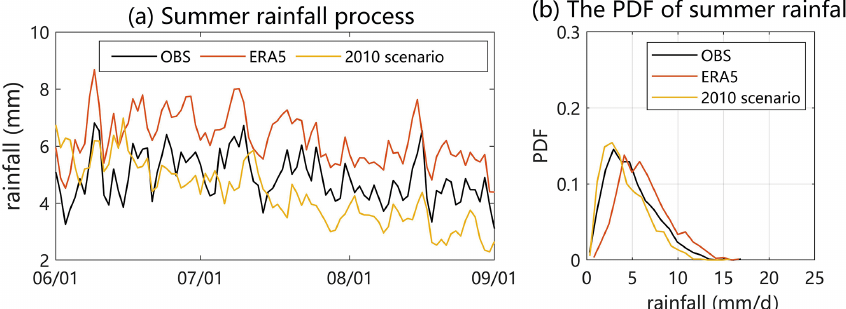
Figure 5. (a) The basin-averaged summer rainfall processes of the observation, ERA5, and the 2010 scenario. (b) The probability distribution functions of summer rainfall of the observation and ERA5 and 2010